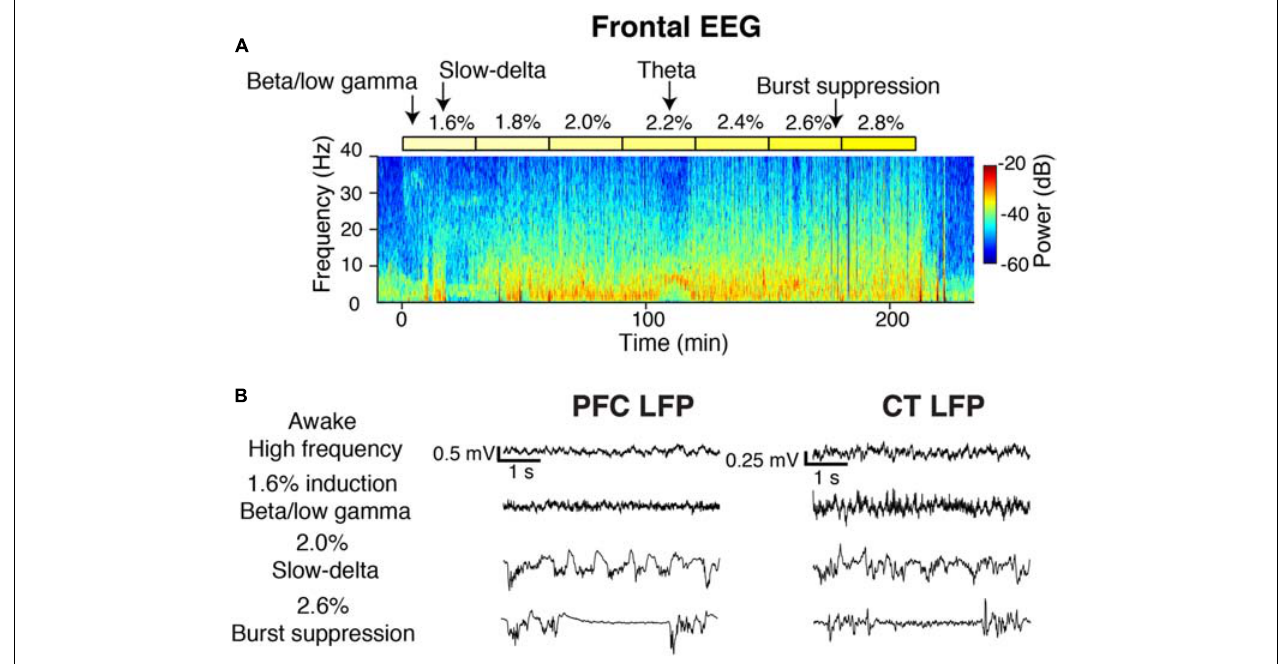
FIGURE 2 | Overview of oscillatory dynamics observed during the 1.6–2.8% sevoflurane ramp. (A) Spectrogram of the frontal EEG from a representative animal during the sevoflurane ramp. Yellow blocks mark periods during which sevoflurane was set to the indicated dose. Arrows point to oscillatory dynamics. From this animal, (B) PFC (left) and CT (right) LFPs from four 5-s